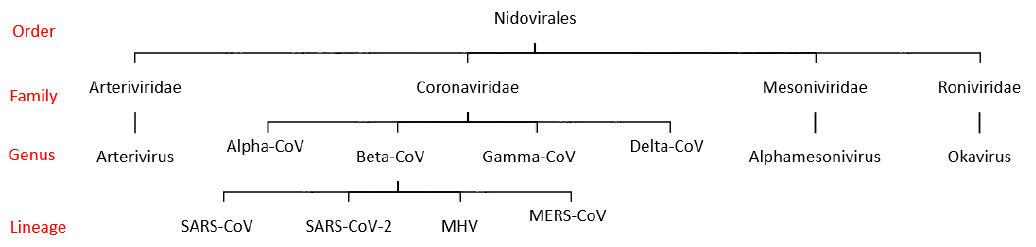
Figure 1. The current taxonomy of the order Nidovirales.